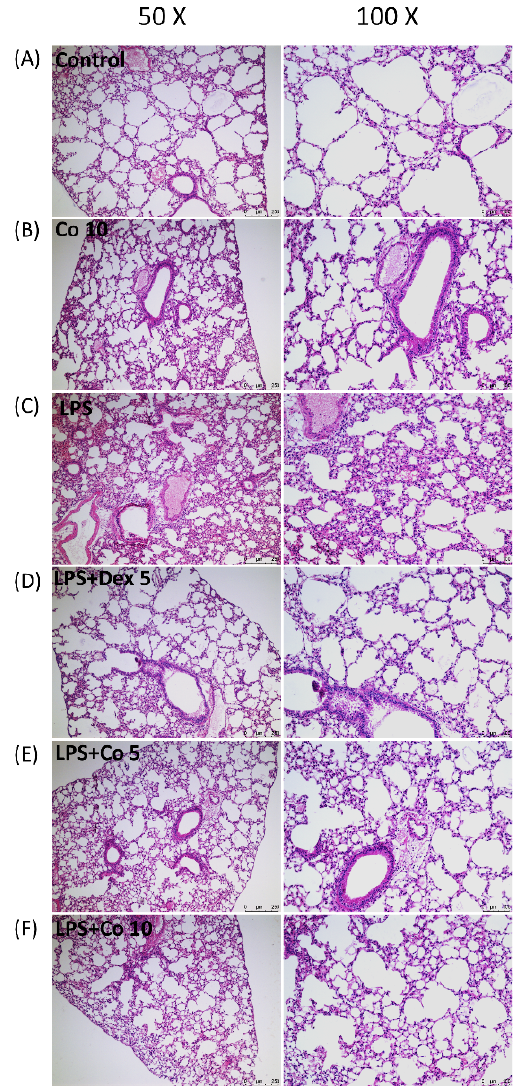
Figure 2. Effects of corilagin on histopathological changes in lung tissues. After intratracheal LPS challenge for 30 min, the mice were administered with Dex (5 mg/kg), corilagin (5 and 10 mg/kg), or equal volume of saline intraperitoneally. Mice were sacrificed after 6 h of LPS challenge. Representative histological changes of the lung tissues obtained from six groups: ( A ) normal saline (control), ( B ) corilagin (10 mg/kg) only, ( C ) LPS, ( D ) LPS + dexamethasone (5 mg/kg), ( E ) LPS + corilagin (5 mg/kg), and ( F ) LPS + corilagin (10 mg/kg). (Hematoxylin and eosin staining, 50× and 100× magnifications are shown).